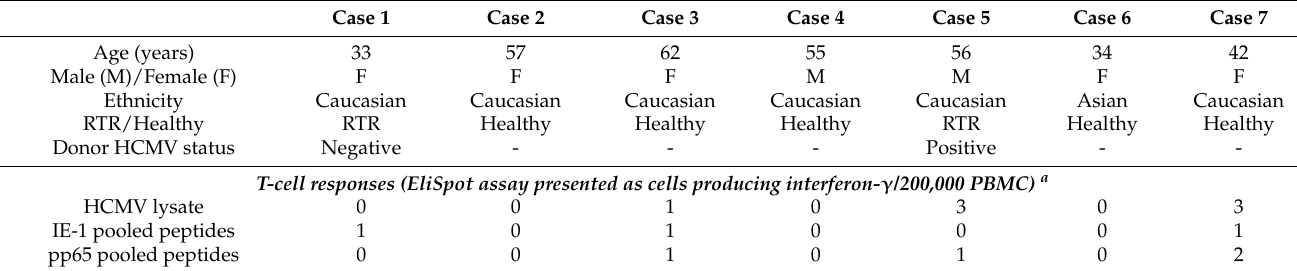
Table 2. Characteristics of seven HCMV seronegative individuals with evidence of HCMV